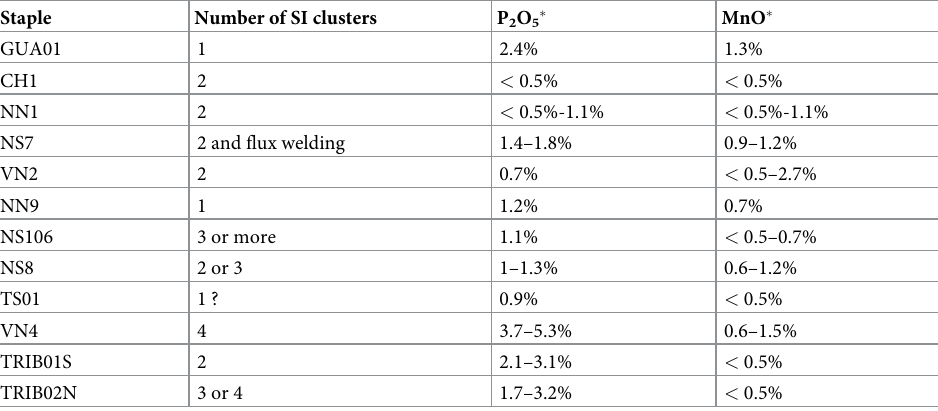
Table 5. Different clusters highlighted by welding lines and major elements analyses and variation in P 2 O 5 and MnO content (given in average weighted content per cluster).